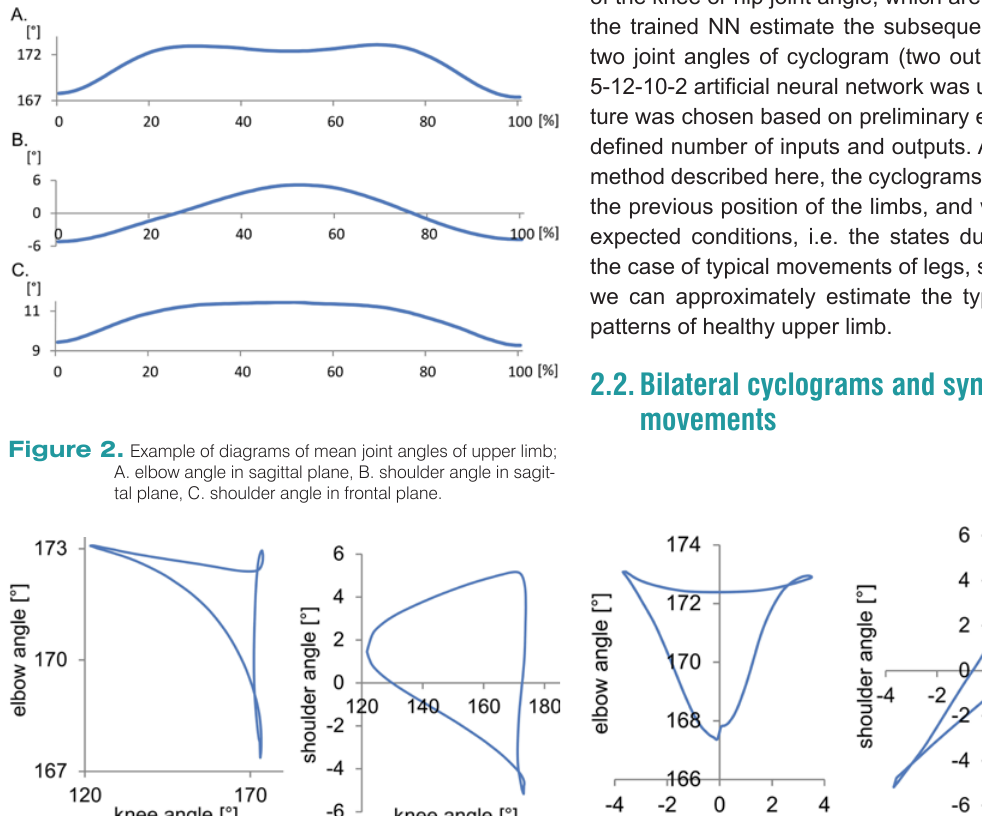
Figure 3. The knee-elbow and knee-shoulder cyclogram of the average joint angles..